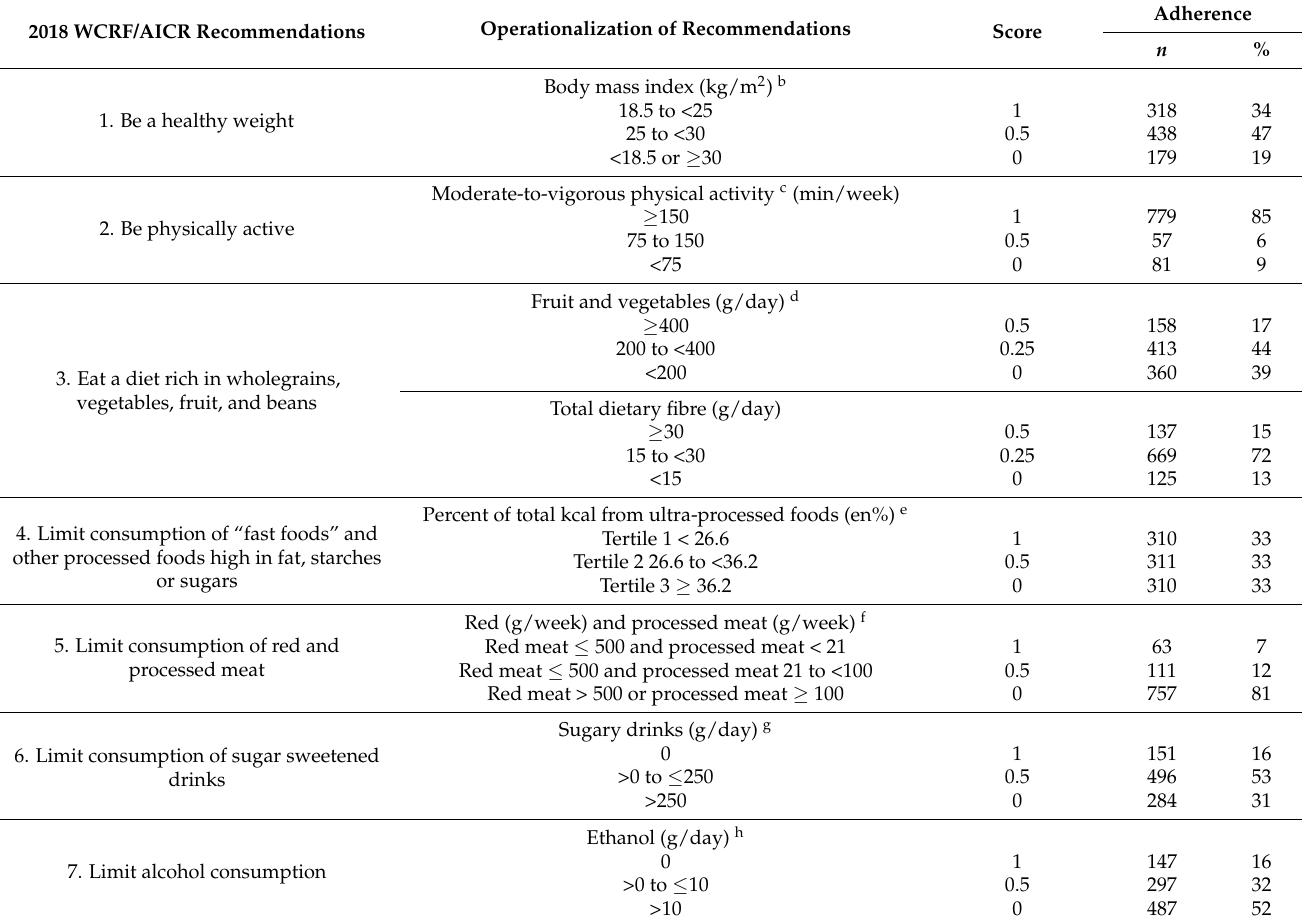
Table 1. World Cancer Research Fund/American Institute for Cancer Research (WCRF/AICR) recommendations and adherence in patients with non-muscle invasive bladder cancer at baseline ( n = 935) a